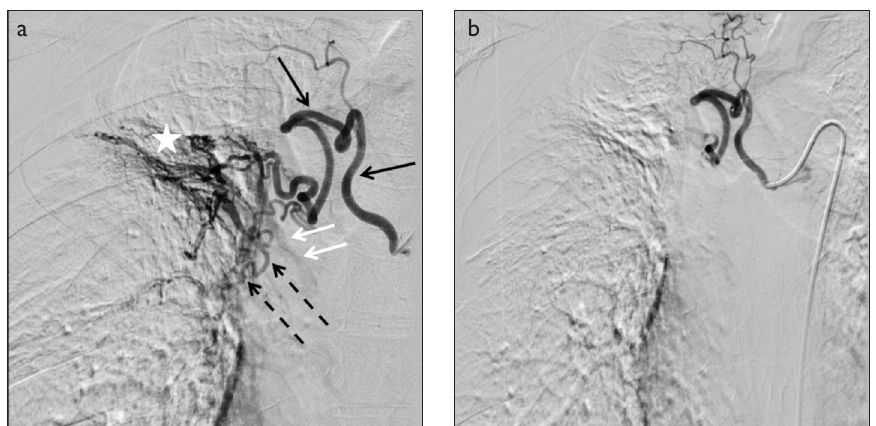
Figure 1. a, b. a) Hypertrophy (black arrows), hypervascularity (star), tortuosity (dotted arrows), bronchopulmonary shunt (white arrows) are seen in the pathologic bronchial artery on a selective right intercostobronchial trunk angiogram. b) Postembolization angiogram demonstrates the cessation of antegrade